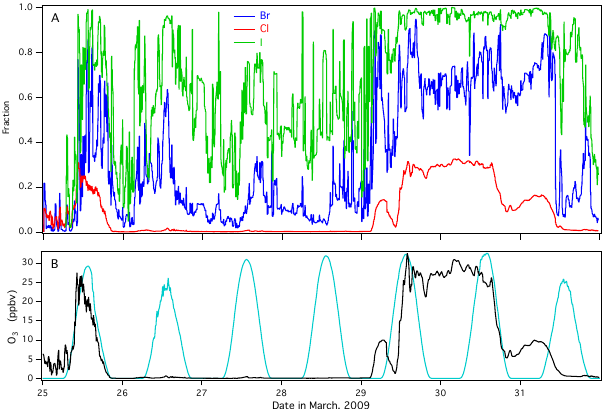
Figure 6. (a) Time-varying fraction of Br (blue), Cl (red), and I (green) atoms that react with O 3 across the 7 days of the simula- tion. (b) Time series of observed ozone mole ratios with radiation is shown as the cyan trace as a reference. Time is expressed in Alaska Standard